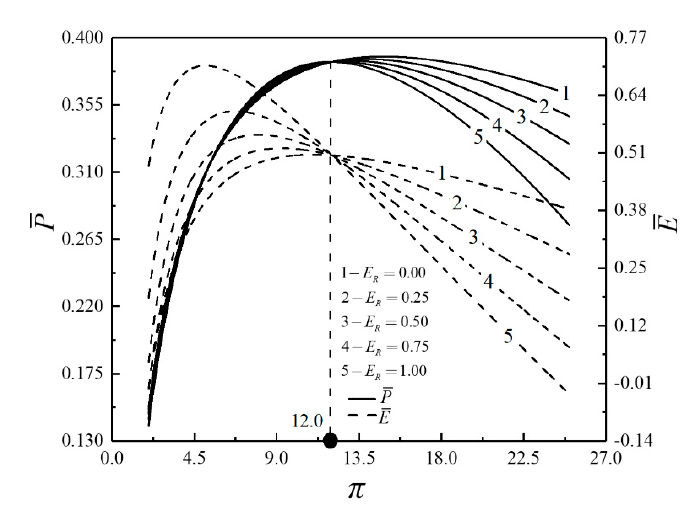
π with different R E .